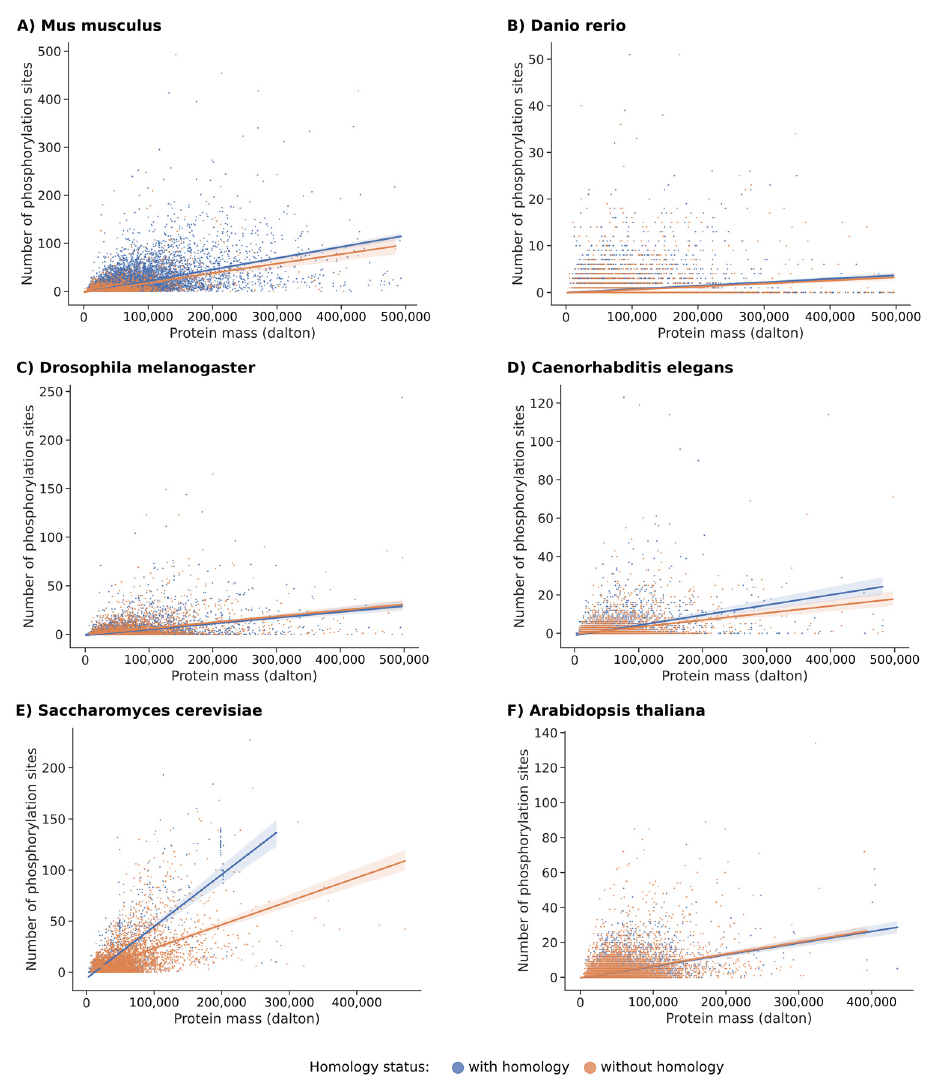
Figure 4. A comparative plot of the relationship between masses and the number of phosphorylation sites for six species of different order. Each phosphorylated protein with a mass of less than 500,000 daltons and with less than 500 phosphorylation sites was considered. Data in blue are for proteins that have at least one homolog in another species, while data in orange are for proteins without homolog. Regressions lines are drawn with a confidence interval of 0.95 (highlighted using translucent bands around the regression line). The species under consideration are ( A ) Mus musculus , ( B ) Danio rerio , ( C ) Drosophila melanogaster , ( D ) Caenorhabditis elegans , ( E ) Saccharomyces cerevisiae , and ( F ) Arabidopsis thaliana.